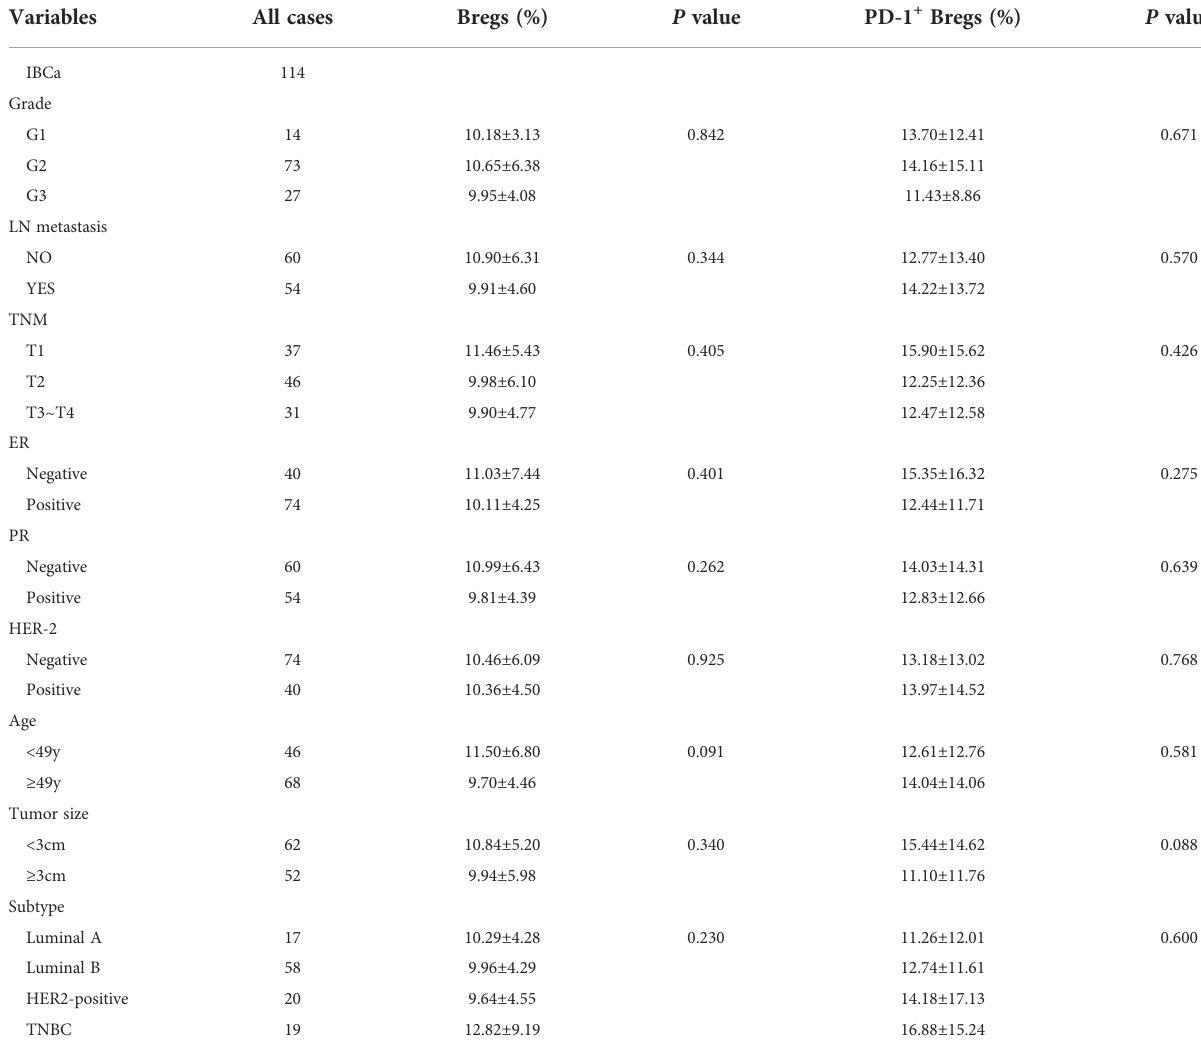
TABLE 2 Relationship between the proportion of Bregs and its subset in PBMCs and the clinicopathological parameters of IBCa patients.